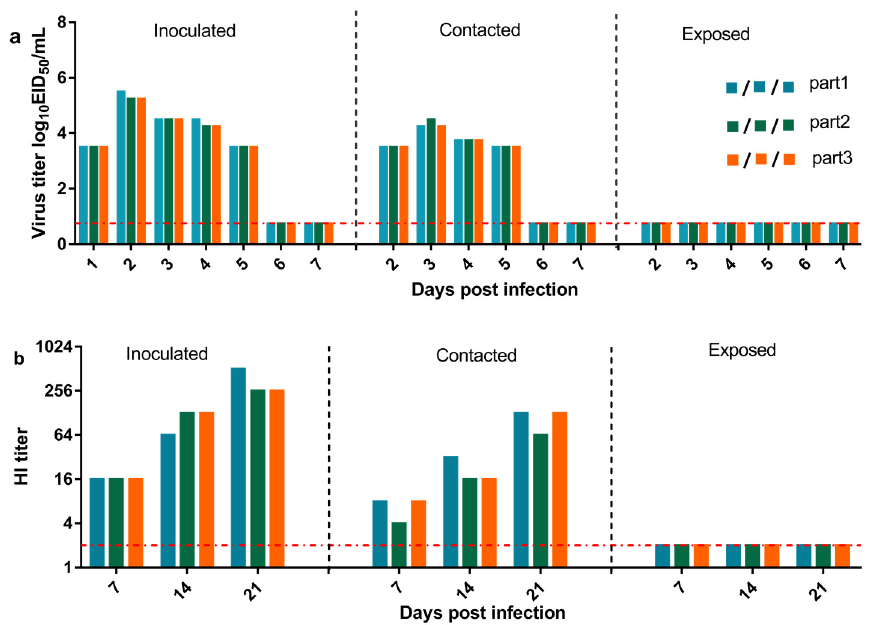
Figure 7. Replication and transmission in guinea pigs of H3N2 CIVs. ( a ) The vertical axis represents the titers of influenza viruses recovered from nasal washes in virus-inoculated, contacted, and exposed guinea pigs. ( b ) HI antibody titers of the animals. Each color bar represents an individual animal. The dashed line represents the limit of detection.